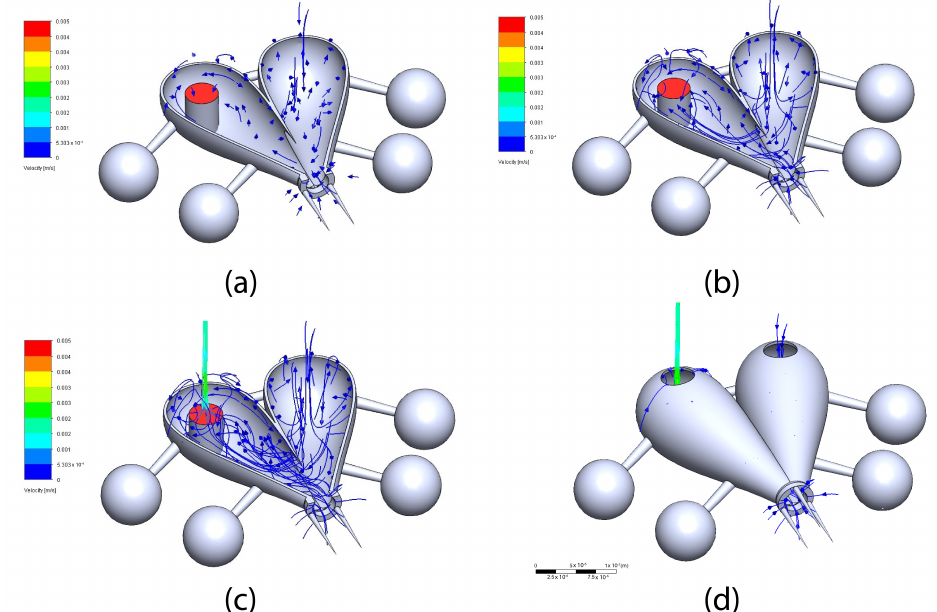
Figure 6. Simulation results of fluid flow due to the convection current created by a heating source (red marked) inside the microbots (sectional view) at different time stamps ( a ) 3 s, ( b ) 6 s, ( c ) 10 s, and ( d ) microbot model without the